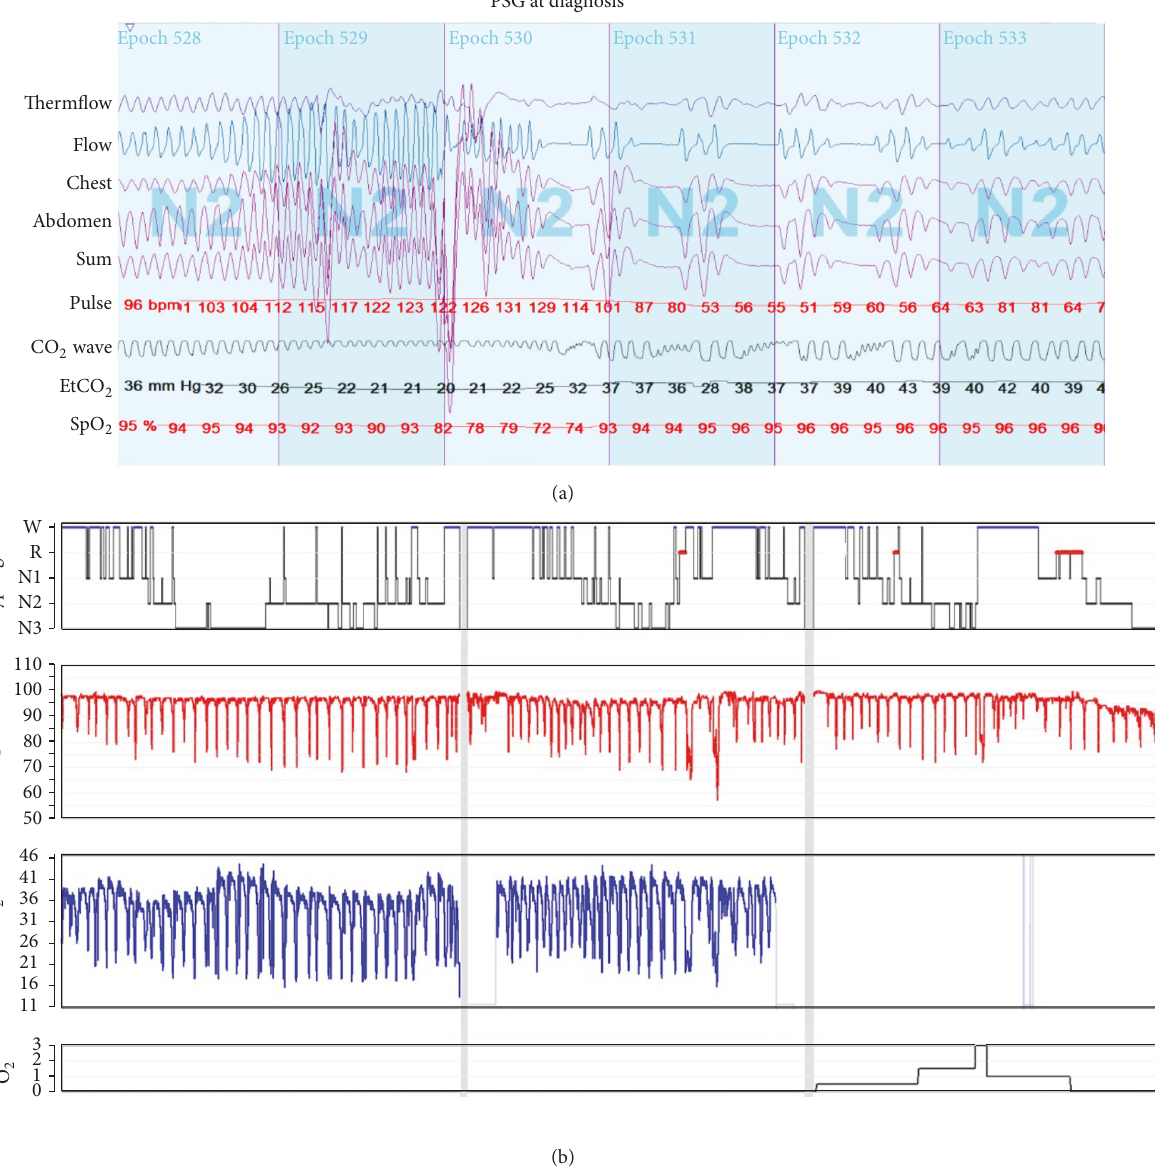
Figure 2: (a) 3-minute polysomnographical recording showing the periodic breathing pattern. (b) Hypnogram from the entire night illustrating the sleep stages; W: wakefulness, R: REM, N1–N3: non-REM sleep (stage 1–3), SpO 2 : oxygen saturation, and EtCO 2 : end tidal carbon dioxide. Supplemental oxygen was added during the last third of the